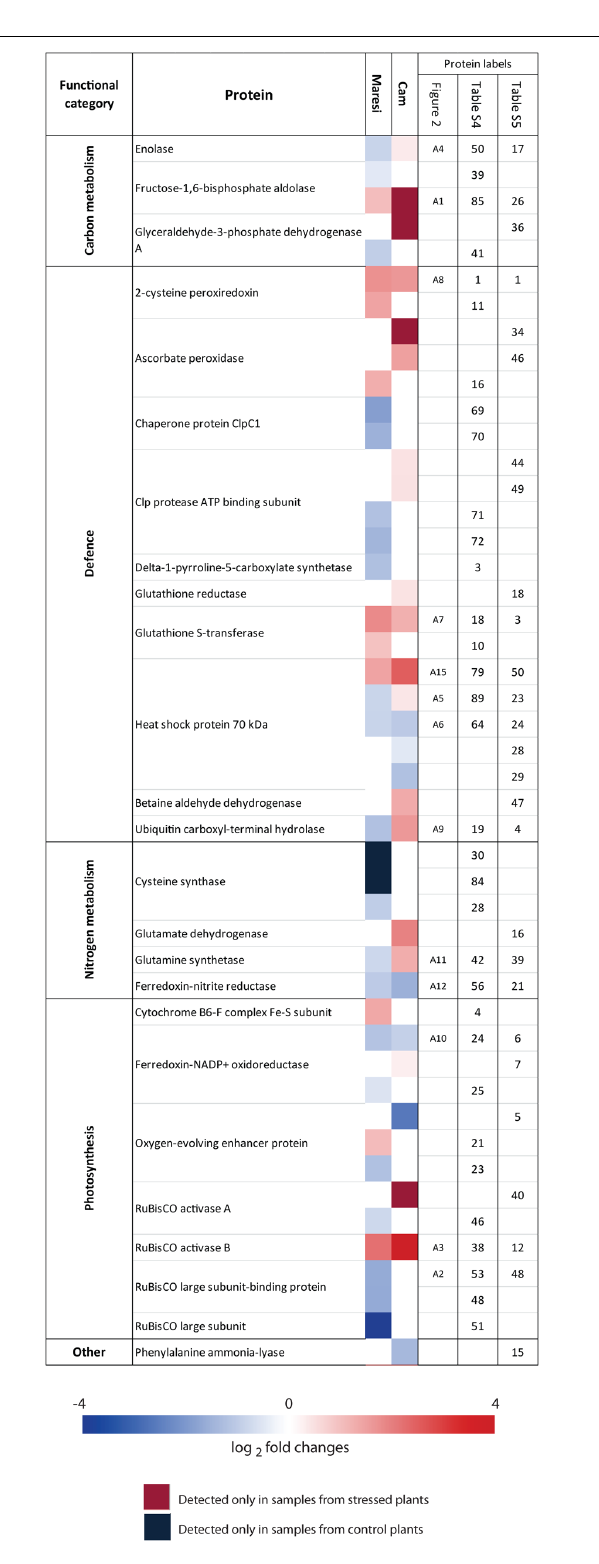
FIGURE 5 | Drought-induced changes in the accumulation levels of selected proteins identified in leaves of both tested barley lines. Additional data are shown in Supplementary Tables S4 and